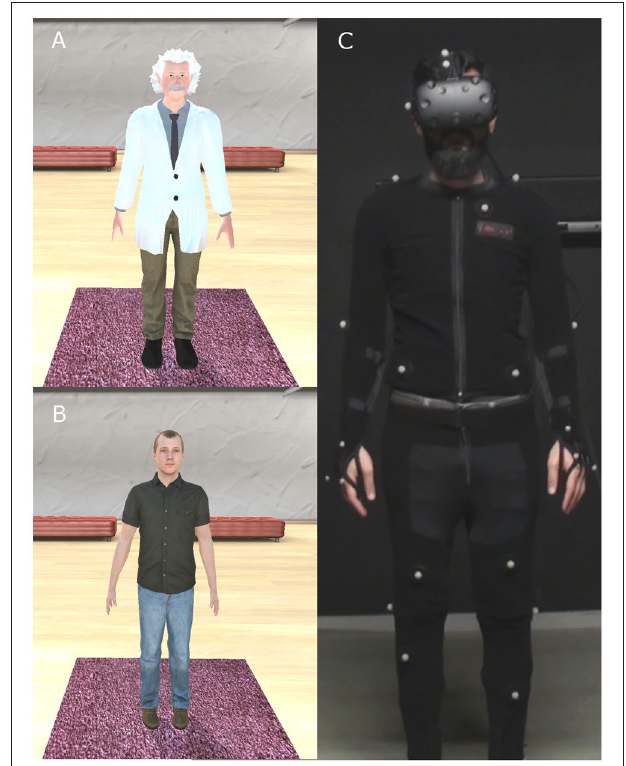
FIGURE 1 | The experimental setup. The body of the participant was substituted by a gender-matched VB, viewed from 1PP, onto which body and head movements were mapped in real time. (A) The Einstein virtual body. (B) The Normal virtual body. (C) Participants were fitted with an HTC VIVE head-mounted display, and their body movements were tracked by 37 OptiTrack